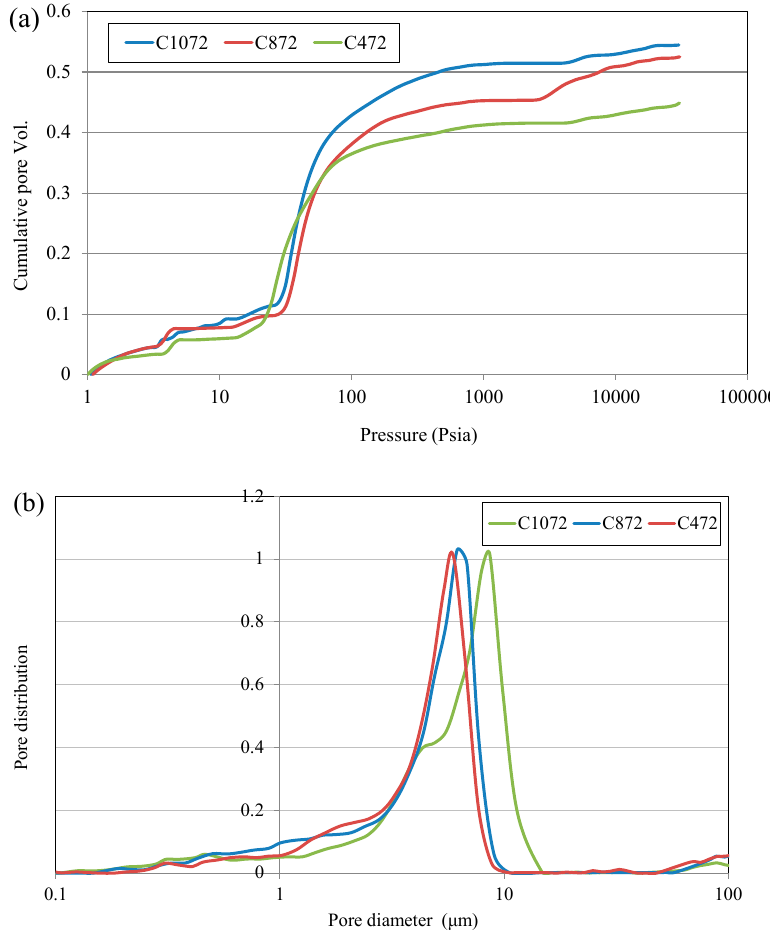
Figure 5. MIP test results for samples with different b/w ratios and solid content ( a ) cumulative pore volume; ( b ) pore size distribution